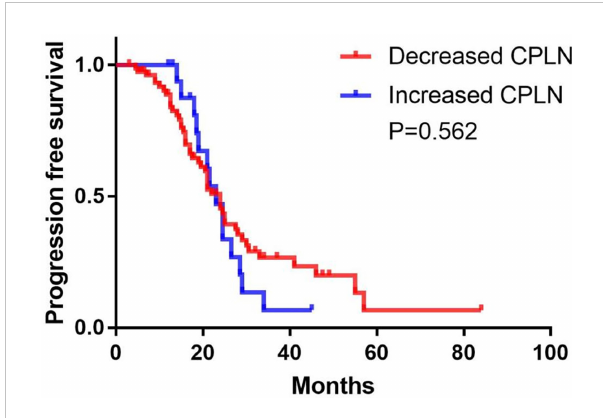
FIGURE 8 Progression-free survival in patients with increased versus decreased in the size of cardiophrenic lymph nodes